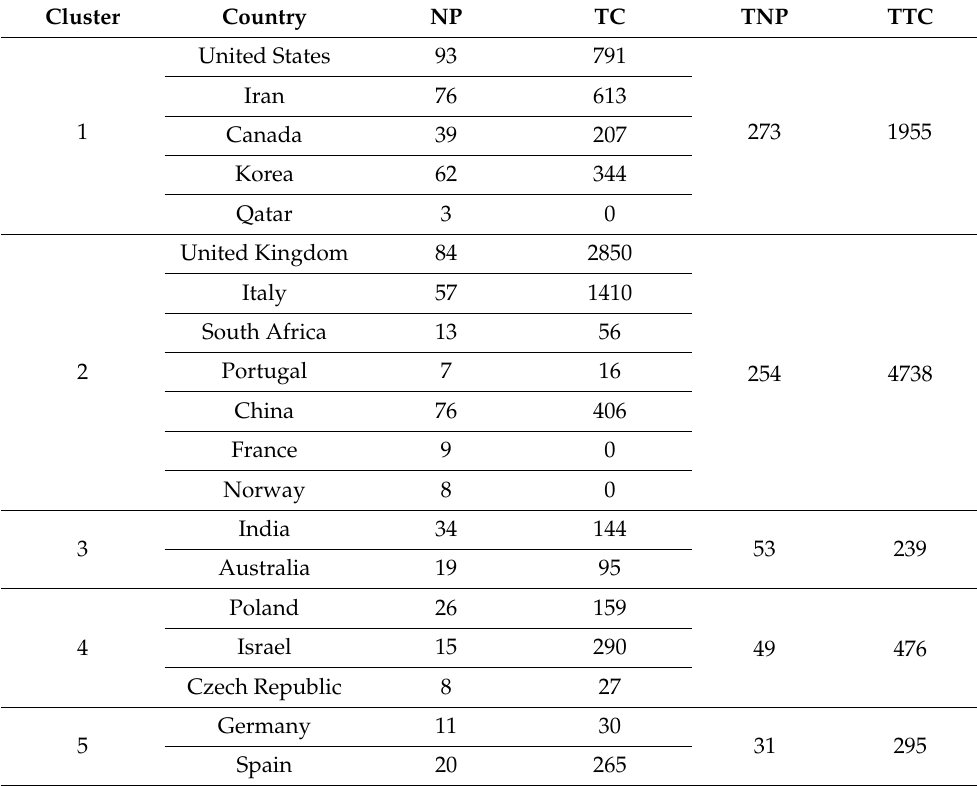
Figure 6. Collaboration network for countries. Node size represents the number of publications and link represents the collaboration among the countries. Table 3. Countries collaboration, production, and citation data.